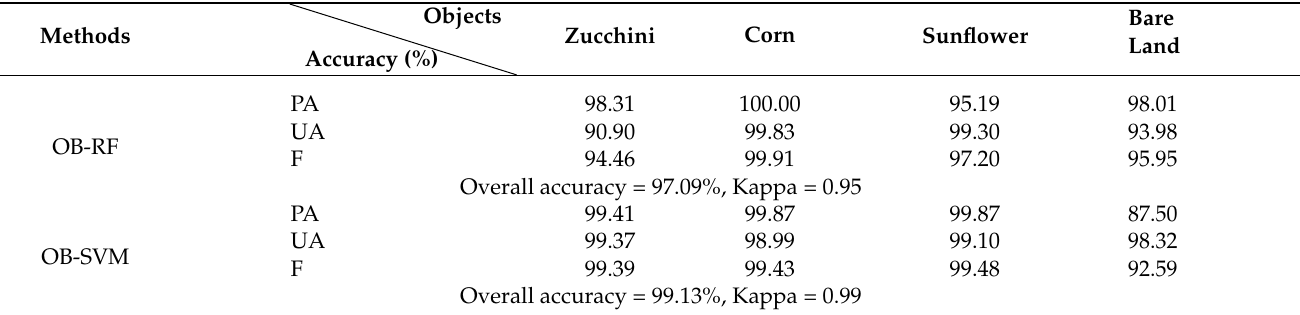
Figure 8. Classification results of OB-SVM model. (( A ) classification result of OB-SVM model in study area 1; ( B ), classification result of OB-SVM model in study area 2; ( C ) classification result of OB-SVM model in study area 3). Note: OB-SVM stands for support vector machine classification model. Table 7. Accuracy evaluation of classification results for SA1.